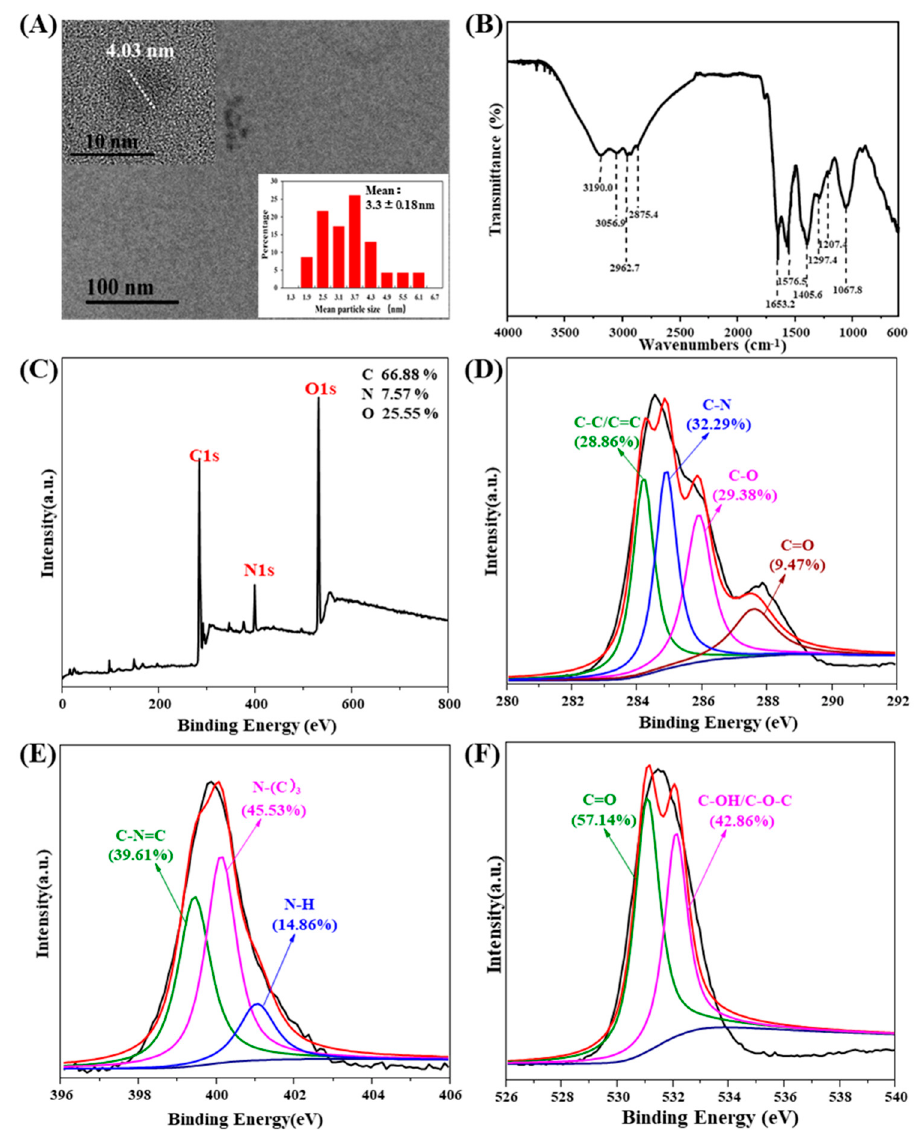
Figure 1. Morphological and spectroscopy analysis of the cyanobacteria carbon quantum dots (CQDs). ( A ) Transmission electron microscope image and the particle size distribution; ( B ) Fourier-transform infrared spectrum; ( C ) X-ray photoelectron spectroscopy (XPS) full-survey spectrum; ( D ) XPS high-resolution scan of C1s; ( E ) XPS high-resolution scan of N1s; ( F ) XPS high-resolution scan of O1s.